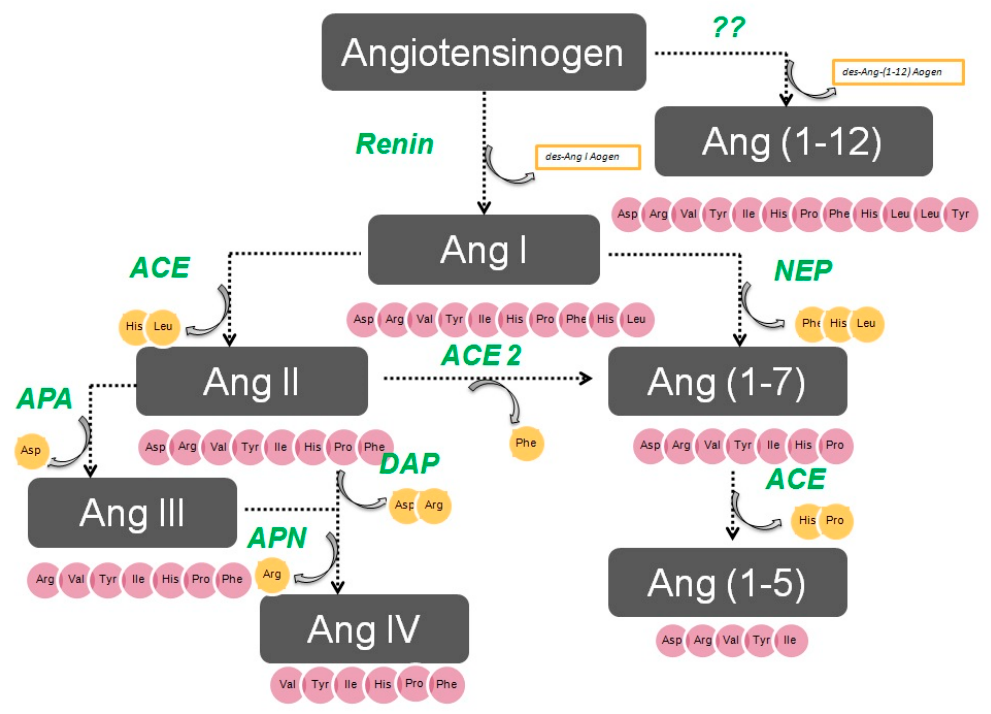
Figure 1. The renin–angiotensin